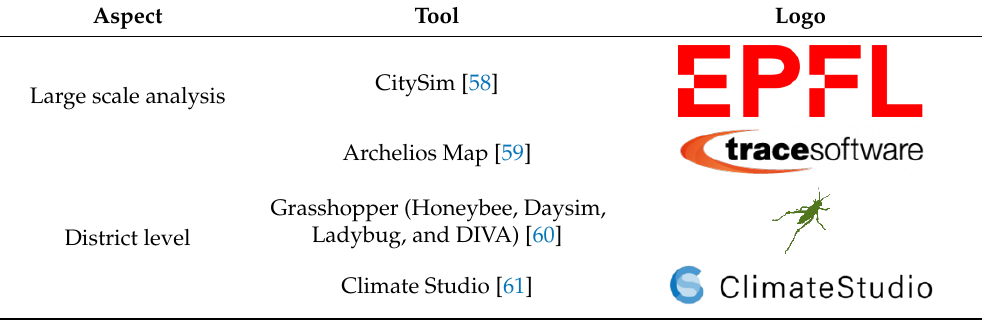
Table 4. Models used for assessing the solar potential at urban level (Source: Author ’ s elaboration).